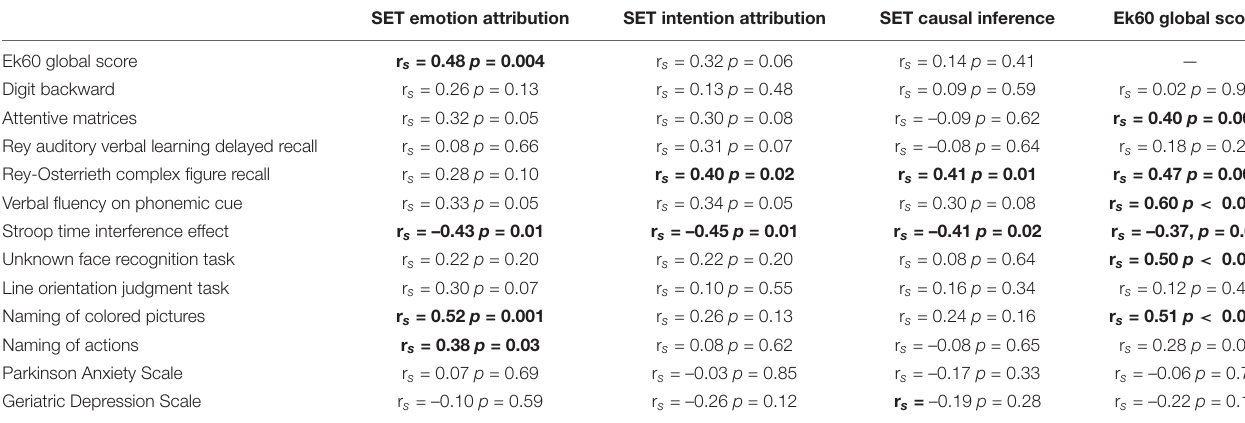
TABLE 4 | Partial correlations between social tasks, cognitive, and behavioral